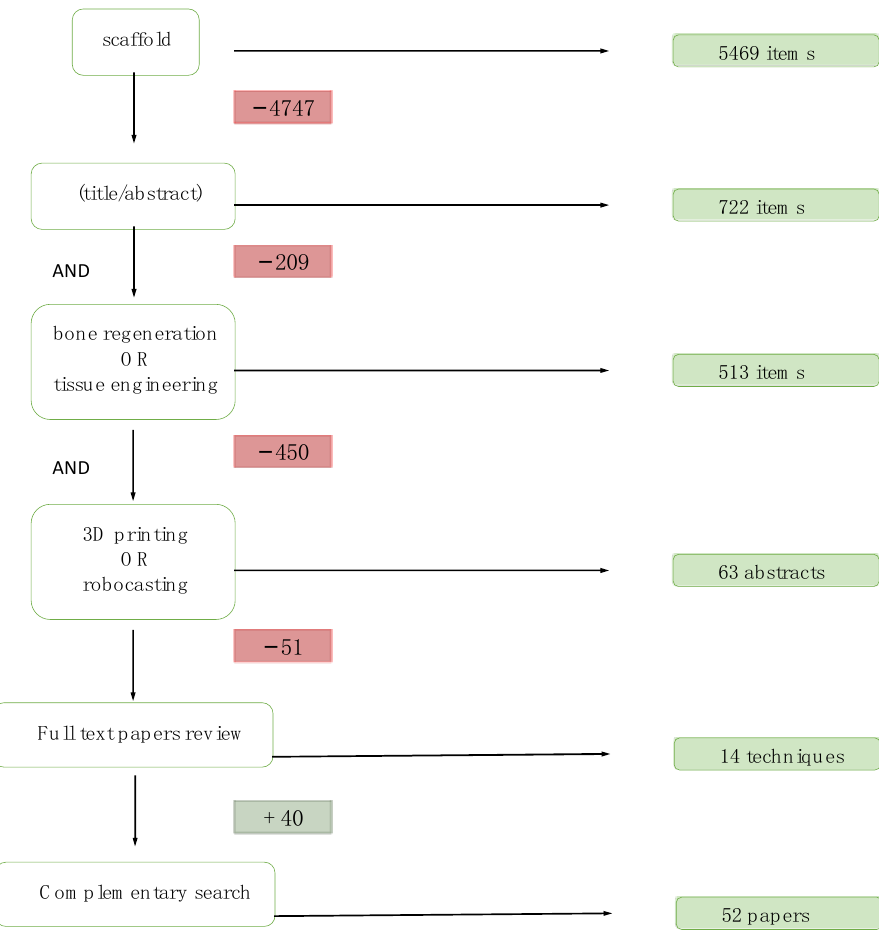
Figure 1. Flow chart of the search strategy.